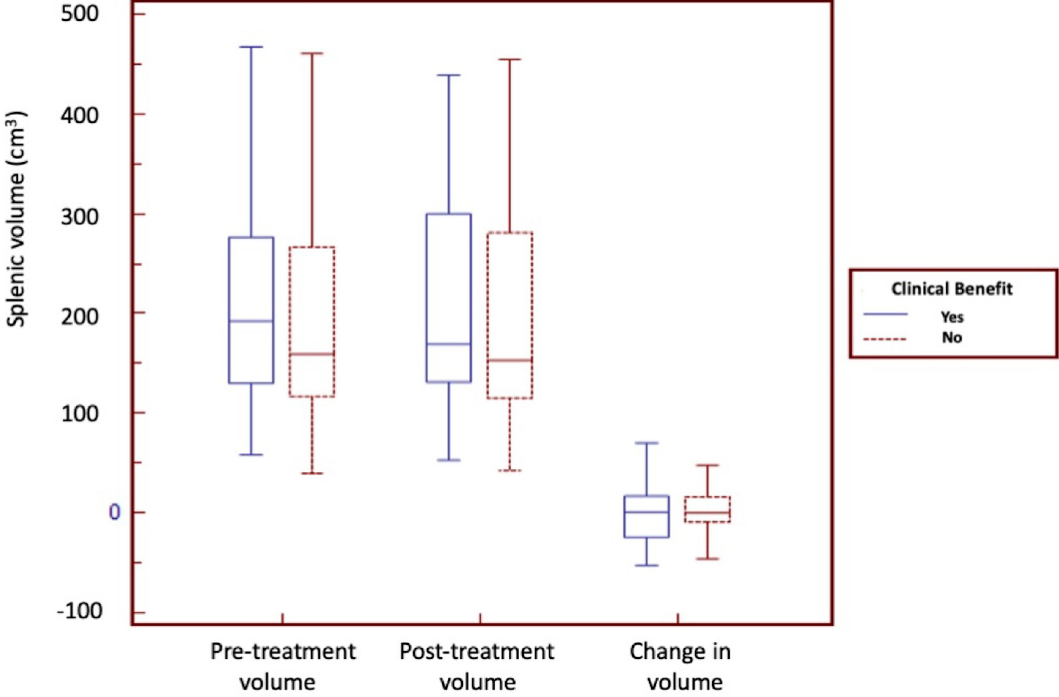
Fig 2. Splenic volume does not show significant changes in NSCLC patients with and without clinical benefit treated with pembrolizumab. The boxplots show the median spleen volume of NSCLC treated with pembrolizumab at baseline, after 12 weeks of treatment and the change in splenic volume between patients with and without clinical